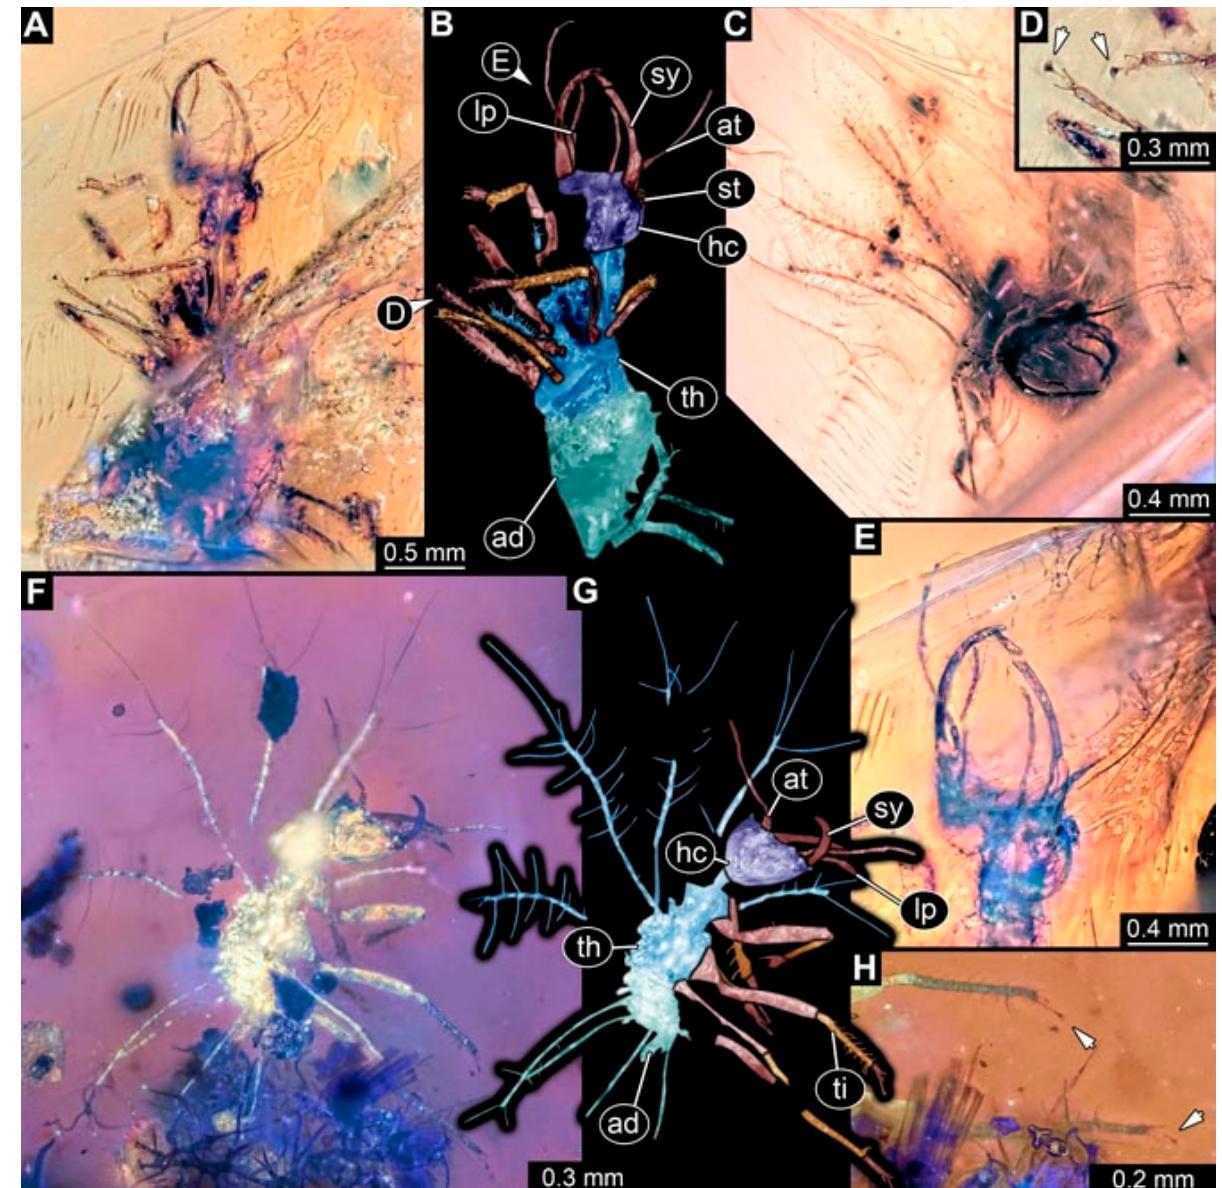
Figure 32. Two specimens in Myanmar amber. ( A – E ) Specimen 4857 (PED 0837). ( A ) Ventral view. ( B ) Ventral view, colour-marked. ( C ) Anterior view. ( D ) Close-up of trunk appendages with empodia (arrows). ( E ) Close-up of head capsule in dorsal view. ( F – H ) Specimen 4853 (PED 0754). ( F ) Dorsal view. ( G ) Dorsal view, colour-marked. ( H ) Close-up of trunk appendages with empodia (arrows). Abbreviations: ad = abdomen; at = antenna; hc = head capsule; lp = labial palp; st = stemmata; sy = stylet; th = thorax; ti = tibia.